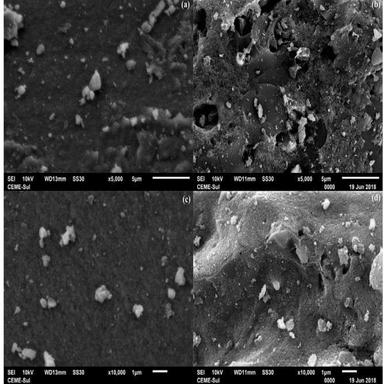
SEM images of (a) NiFe2O4 5000 (b) NiAC 5000 (c) NiFe2O4 10,000 (d) NiAC 10,000.